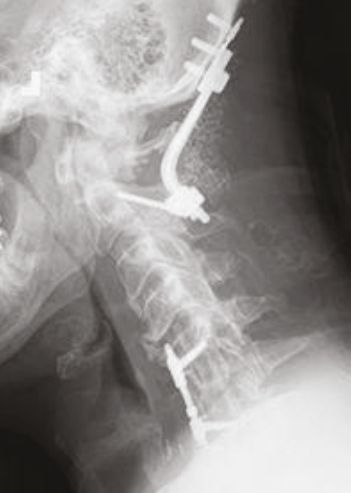
Figure 7: Postoperative lateral radiograph: occiput-C2 fi xation with bilateral C2 pars screws and occiput plate connected with precontoured occiput cervical rods. Past surgical history of C5 – C7 anterior arthrodesis.